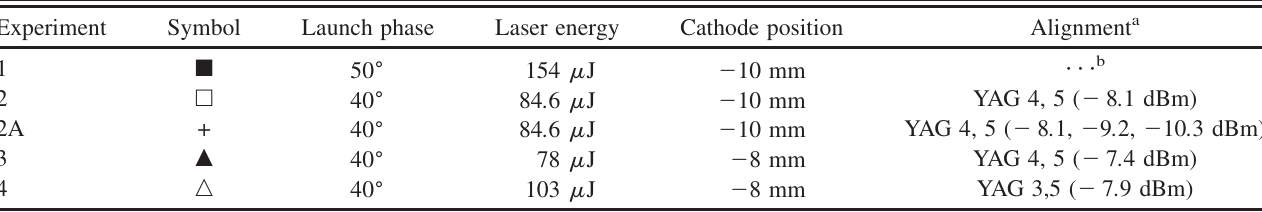
TABLE III. Measurements of beam energy vs transmitted rf power.